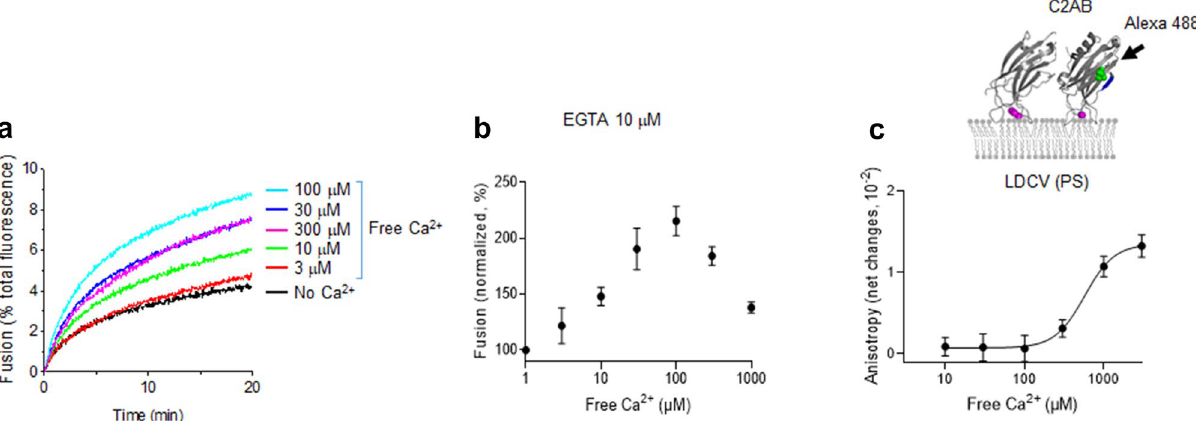
Figure 3. EGTA reproduces ATP effect on Ca 2+ -dependent LDCV fusion and the C2AB binding to LDCVs. ( a , b ) LDCV fusion using a lipid-mixing assay as described in Fig. 2c at different concentrations of Ca 2+ in the presence of 10 μM EGTA, instead of ATP. ( a ) Representative trace of dequenching of donor fluorescence (NBD). ( b ) Dose–response curve of LDCV fusion at various free [Ca 2+ ]. Fusion is normalized as a percentage of control (No Ca 2+ ). ( c ) Ca 2+ dose–response curve for C2AB binding to LDCVs in the presence of 10 μM EGTA using anisotropy as described in Fig. 2a. Data in ( b , c ) are mean ± SD from three independent experiments (n = 3). Free [Ca 2+ ] were calibrated using the MaxChelator simulation program. ( a – c ) ATP was not included in buffer: 120 mM K-glutamate, 20 mM K-acetate, 20 mM HEPES–KOH (pH 7.4), 5 mM MgCl 2 , and 10 μM